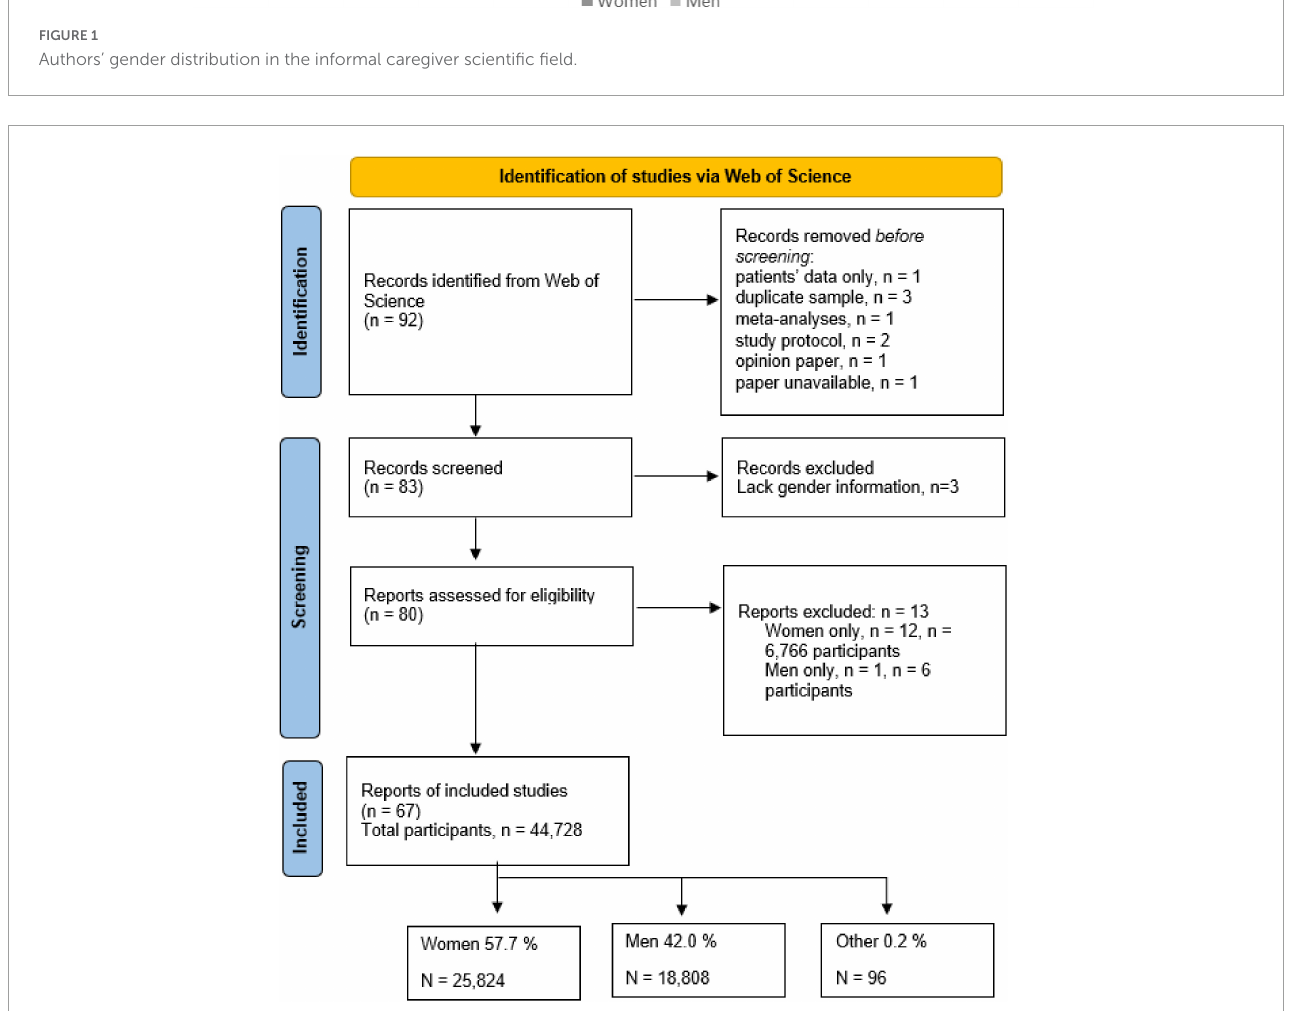
FIGURE2 Informal caregivers’ gender in the analyzed studies. From Page et al.